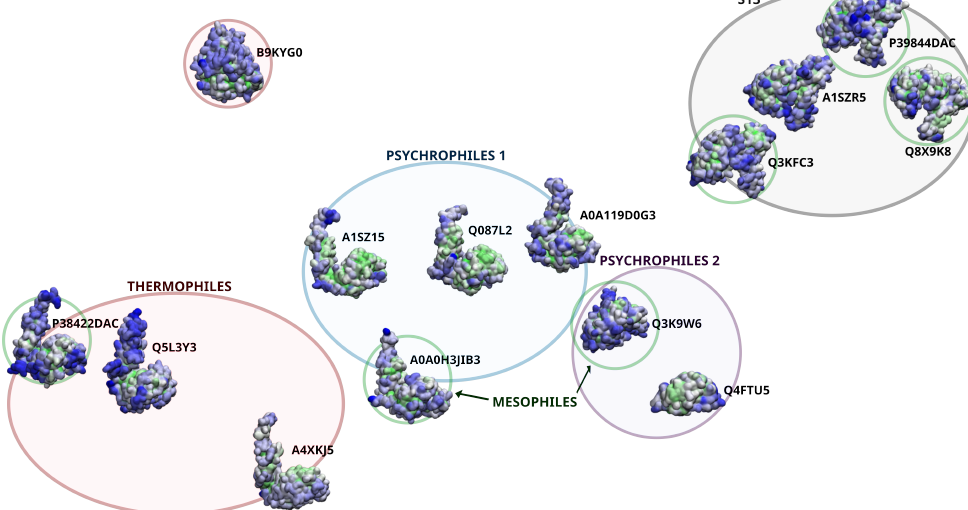
Figure 8. Dynamic solvation index values ( D ), by protein; layout based on Figure 7. D value coloring ranges from green (low) to blue (high). High D values are evident in the tail domain, with psychrophiles showing particularly low values of D on select regions opposite the active